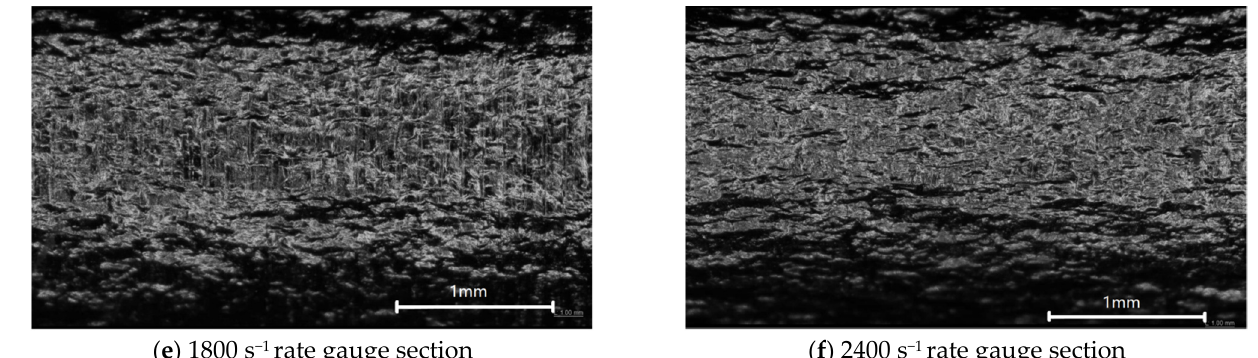
Figure 15. Microscopy observations of tested specimens.